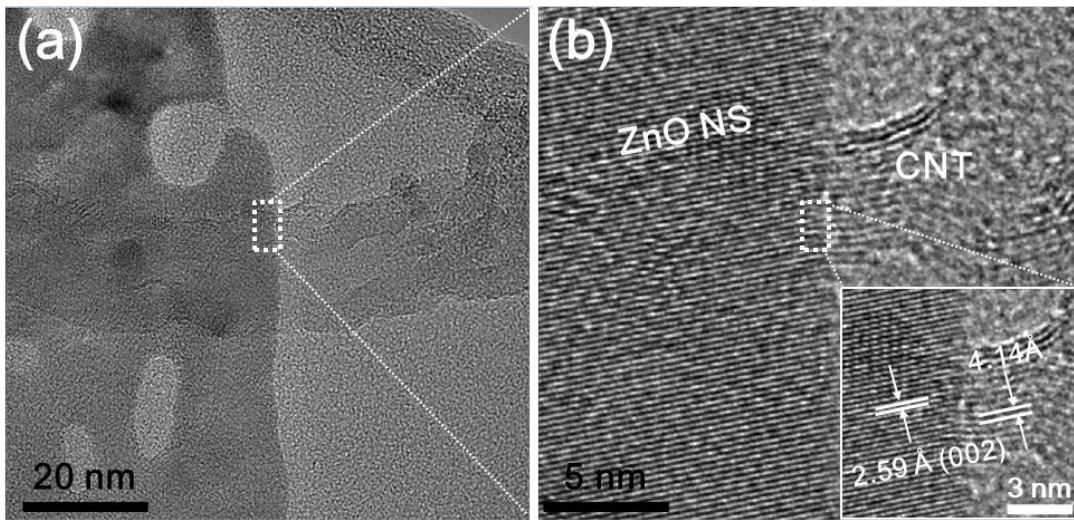
Figure 7. ( a ) High-resolution transmission electron microscopy image of ZnO NS-CNT (355 nm, 10 min) hybrid, where ( b ) clear lattice fringes of ZnO is presented in contact with that of CNT.